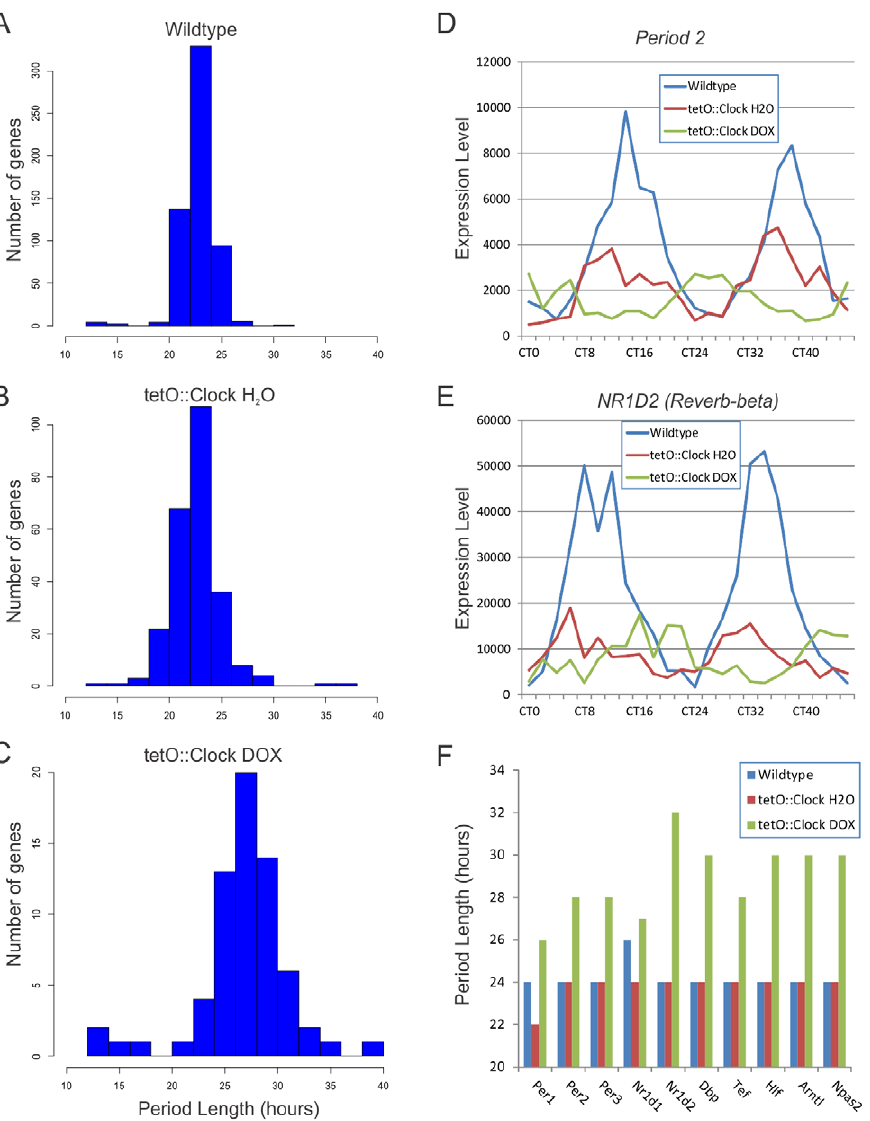
Figure 3. Clock -rescue restores , 24-hour transcriptional rhythms. Panels A–C show histograms of the period lengths of cycling genes in wildtype (A), Clock -rescue (B) and Clock -mutant (C) livers (p , 0.0011 for each genotype/treatment, corresponding to a q , 0.05 in wildtype). Clock - mutant mice have long transcriptional rhythms with periods approximating their behavioral rhythms (mean period=27.6 + / 2 4.5 h), while wildtype and Clock -rescue animals have period lengths of approximately 24-hours (23.7 + / 2 1.7 h and 23.6 + / 2 2.6 h, respectively). Note that the difference in y- axis scales reflects the overall level of rhythmic transcriptional output in these mice. Two components of the core circadian clock, Per2 (D) and Nr1d2 (E), illustrate the long-period phenotype of the Clock -mutant mice. This effect is seen in most core clock genes as well as key circadian output genes (F). Additional examples are shown in Figure S1. The apparent phase difference in Clock -mutant mice compared to wildtype/ Clock -rescue mice is believed to be a consequence of their free-running period length phenotype.